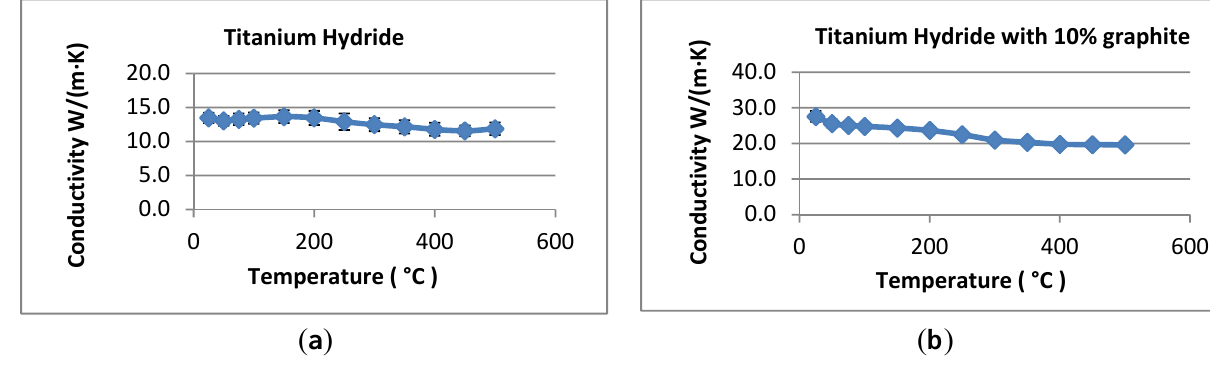
Figure 7. Thermal conductivity of ( a ) titanium hydride and ( b ) titanium hydride with 10% graphite showing thermal enhancement of two times.